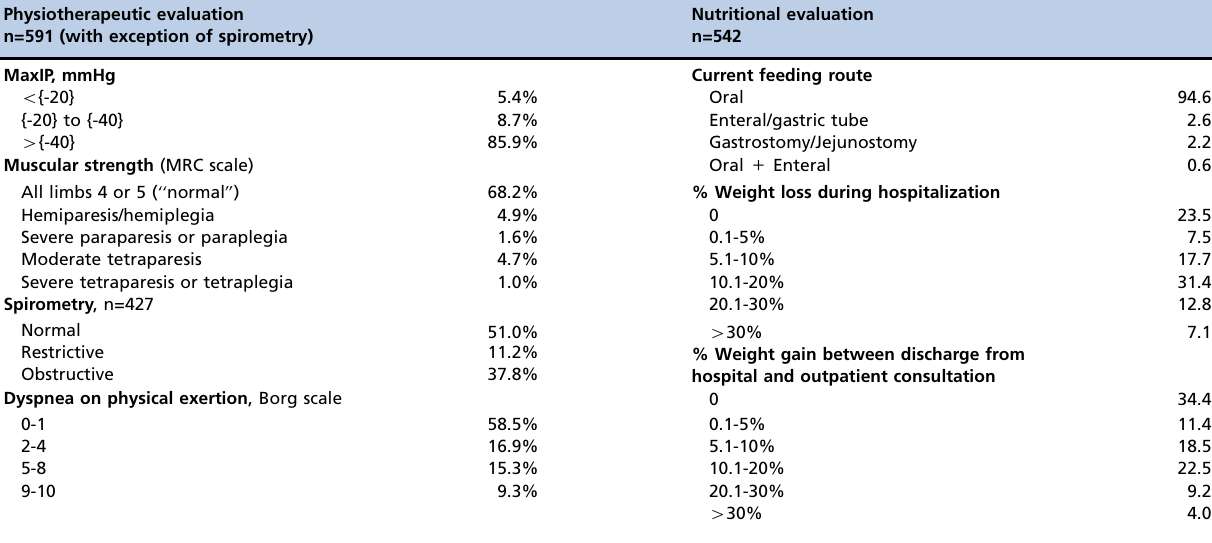
Table 2 - Physiotherapeutic and nutritional evaluation at the post-ICU outpatient clinic. Physiotherapeutic evaluation n=591 (with exception of spirometry)